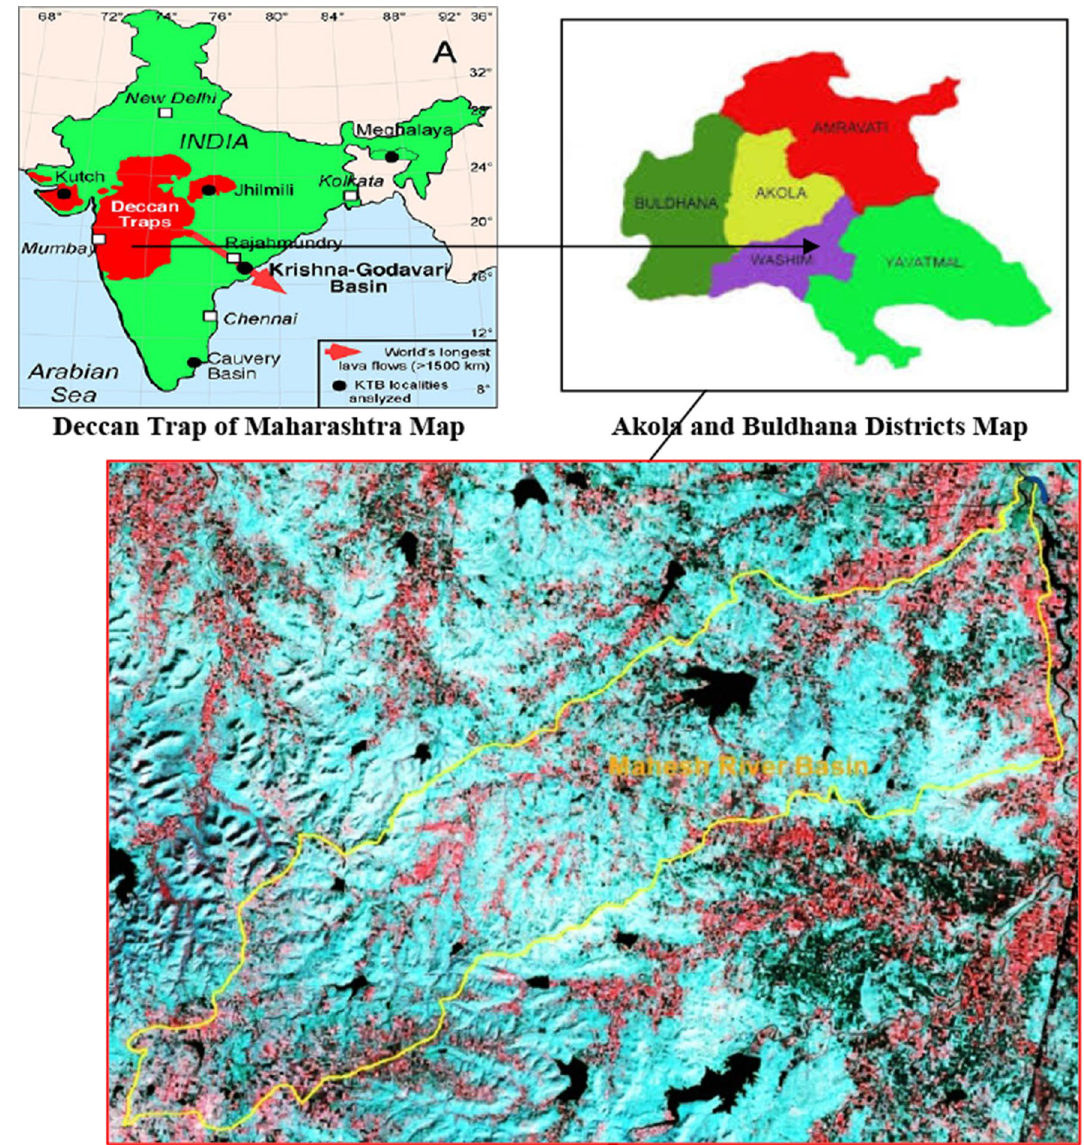
Fig. 2 Location map of the arid